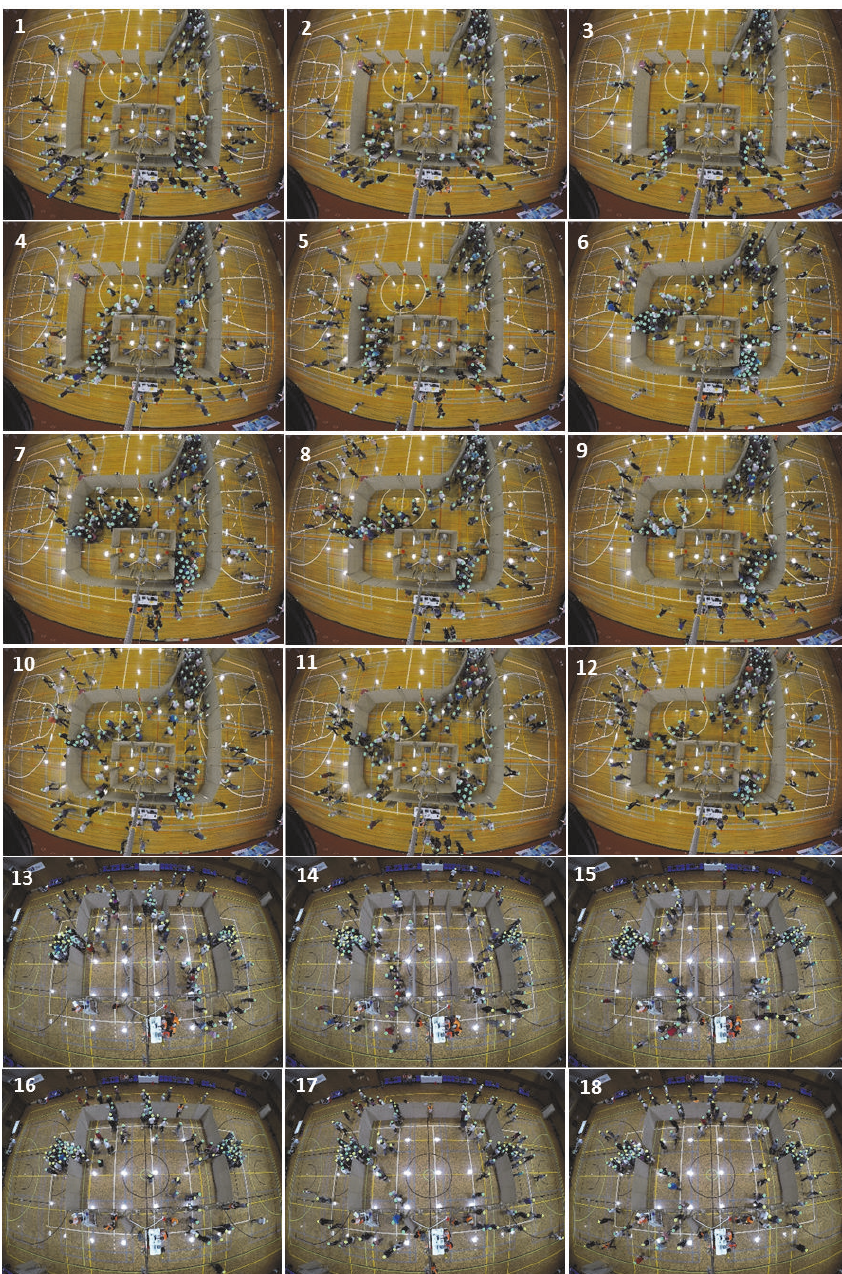
Figure 1: Still images from each experimental scenario. Subplots 1-12 represent the scenarios from the experiment performed in 2015 (with 145 participants) and subplots 13-18 represent the experimental scenarios performed in 2017 (with 114 participants). Within each set of experiments, each scenario is unique and differs from others based on the number of available exits, the locations of exits, or the presence of